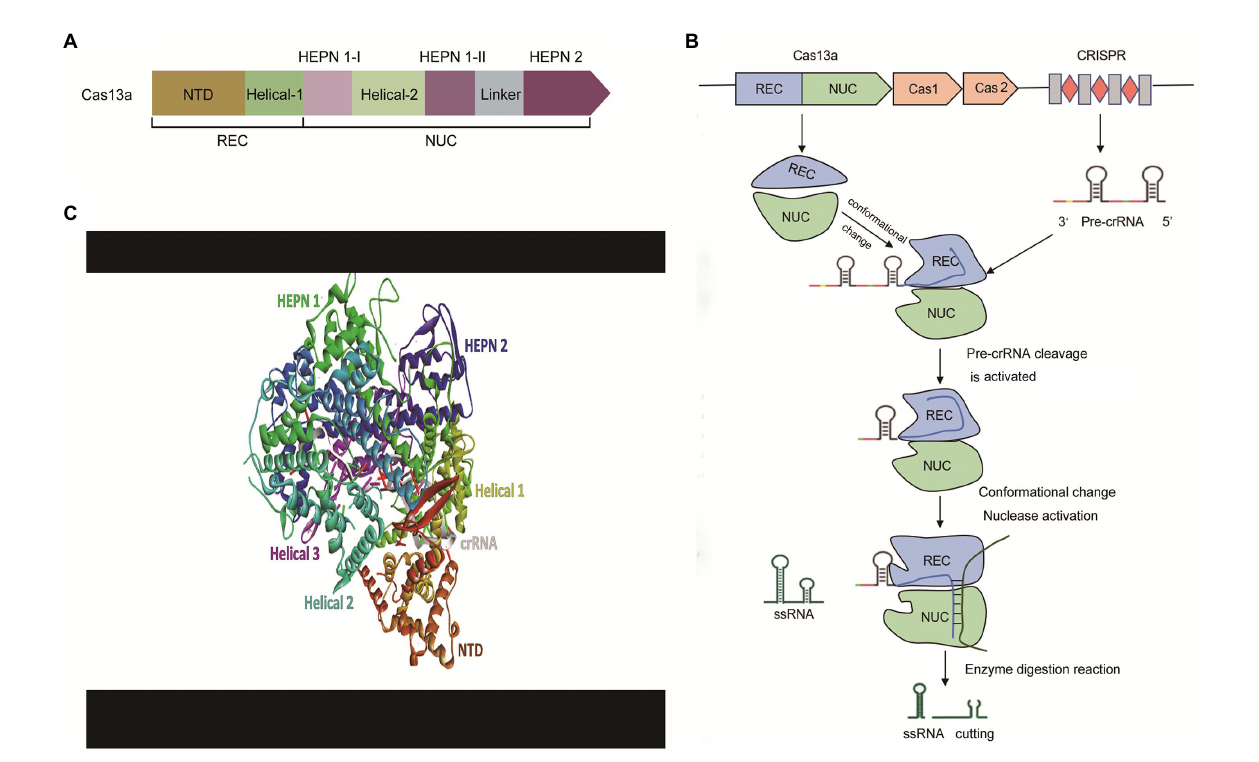
FIGURE 3 The effector modules and mechanism of action of the CRISPR-Cas13a. (A) The architecture of effector modules of Cas13a. Cas13a has a bi-lobed structure comprising a ‘Nuclease’ (NUC) lobe and a ‘Recognition’ (REC) lobe. NUC Lobe contains two distinct but functionally linked endonuclease sites—Higher Eukaryotes and Prokaryotes Nucleotide-binding Domain 1 and 2 (HEPN-1 and HEPN-2) separated by a basic linker/Helical-3 domain, and a Helical-2 domain. The REC lobe encompasses the N-terminal domain (NTD) and the Helical-1 domain, (B) The mechanism of action of the CRISPR-Cas13a. The pre-crRNA recognizes and binds to the REC leaves of Cas13a. Next, Cas13a processes its pre-crRNA to form a stable crRNA-Cas13a complex. Subsequently, the target ssRNA is recruited to the crRNA-Cas13a complex to undergo base-complementary pairing with the matured crRNA resulting in the activation of the Cas13a endonuclease enzyme. Finally, the activated catalytic domain of Cas13cleaves the target sequence, and (C) Crystal structure of Cas13a complex with crRNA. REC, Recognition lobe; NUC, Nuclease lobe; CRISPR, Clustered Regularly Interspaced Short Palindromic Repeats; Pre-crRNA, Precursor CRISPR RNA; ssRNA, Single-stranded